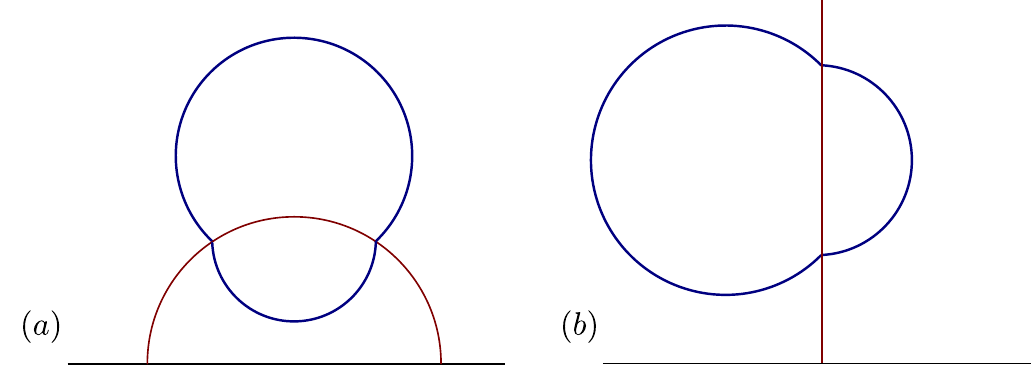
Figure 3 . Two di(cid:11)erent gauge